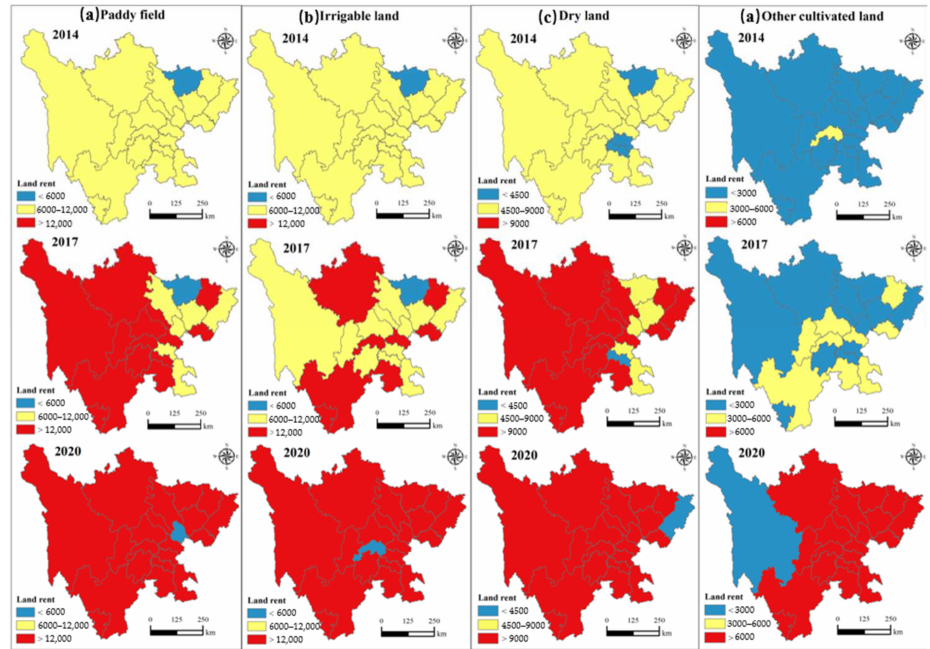
Figure 3. Spatiotemporal variations in farmland rents at prefecture-level